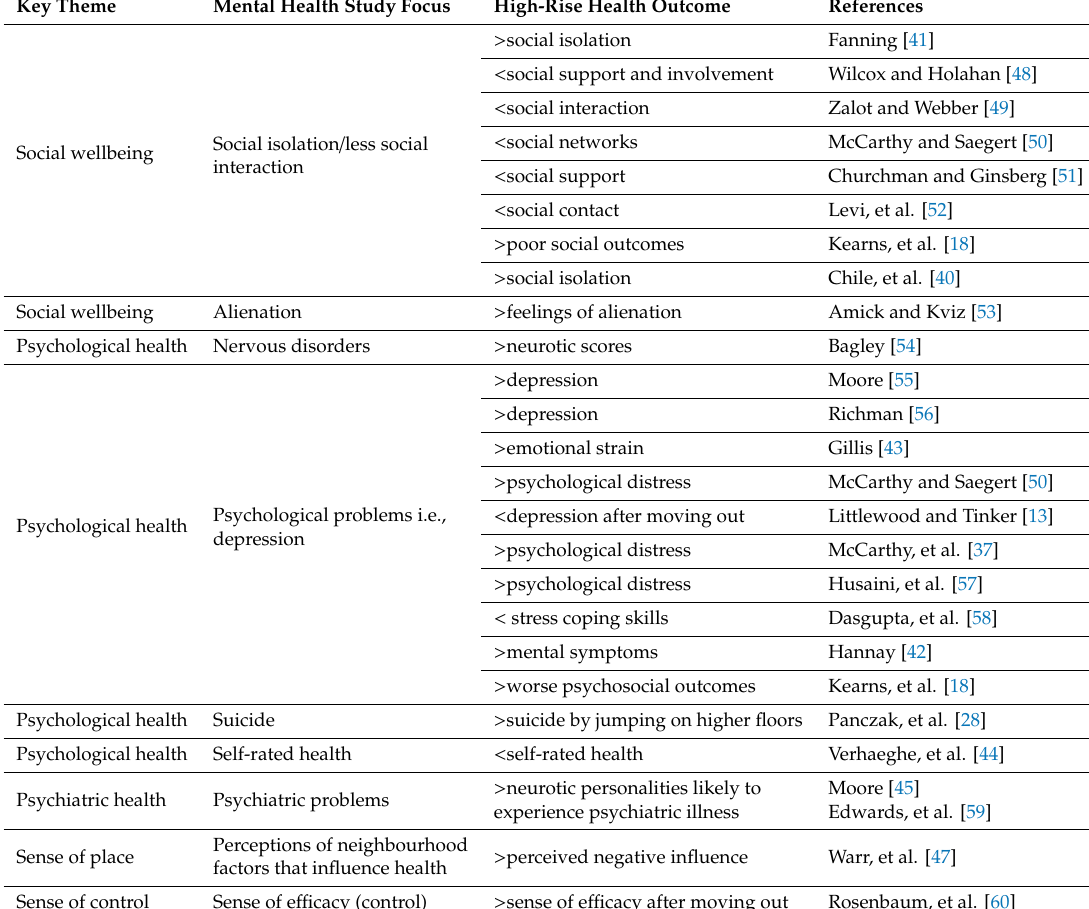
Table 1. Summary of key themes, mental health study focus, high-rise health outcome (in comparison to low-rise / detached houses) for 25 found articles from 1967 onwards assessing the relationship between high-rise housing and mental health across a broad spectrum of mental health categories ( < less, >